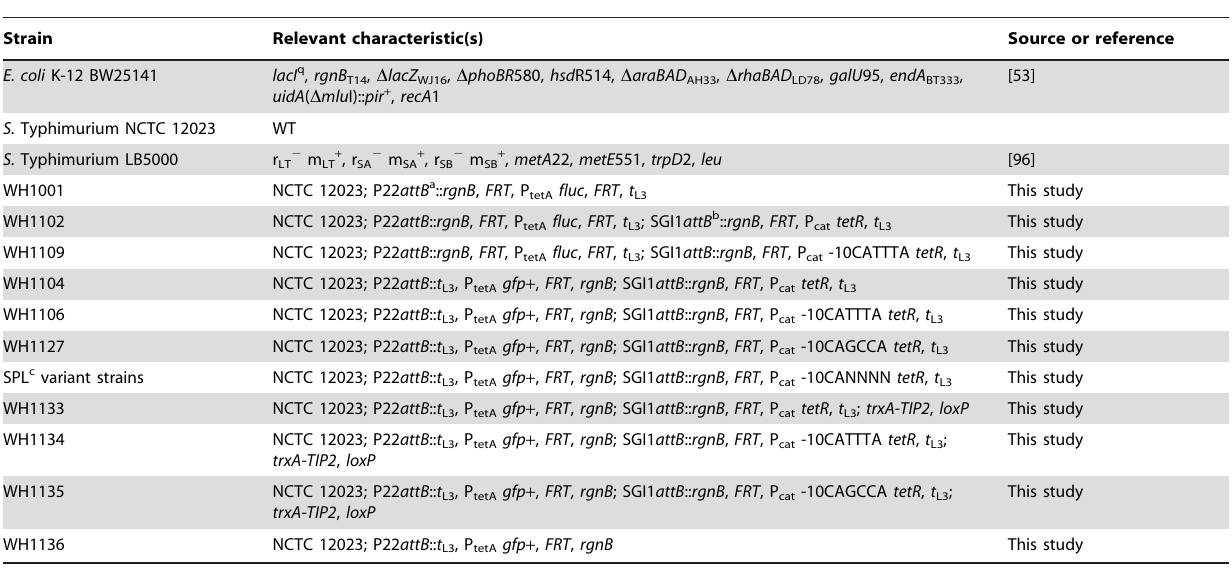
Table 1. Bacterial strains used in this